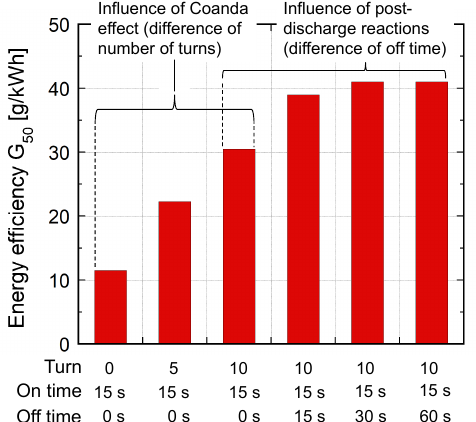
Figure 11. Comparison of the energy efficiency G 50 of indigo carmine decolorization when the Coand˘a effect and post-discharge reactions were introduced in our plasma